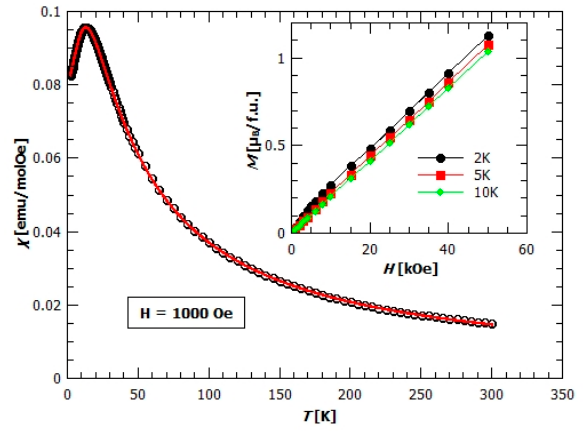
Figure 8. Temperature dependence of the molar magnetic susceptibility χ for compound 1 in the field of 1000 Oe. The red solid line represents a 1D model fit as described in the text. Inset: Field dependence of magnetization, M ( H ), measured at different temperatures.